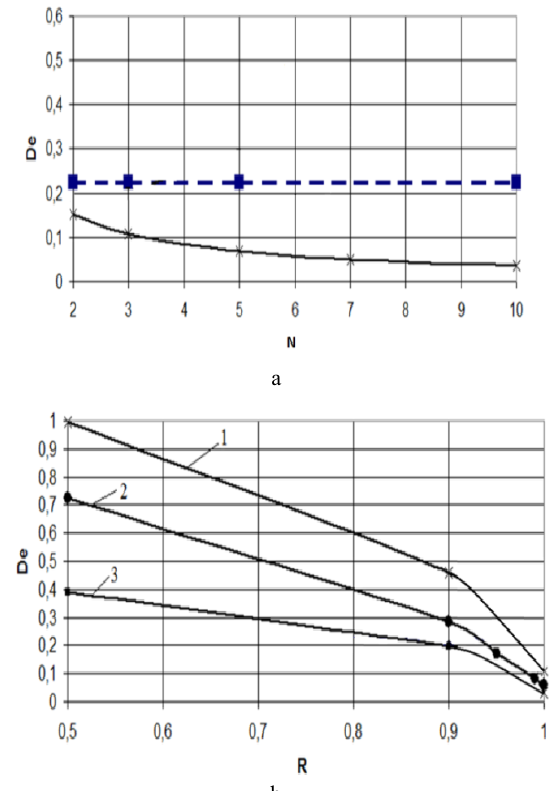
Figure 1. Multizone Image Filtering Efficiency